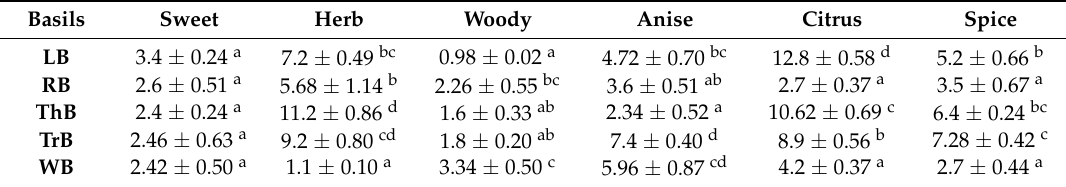
Table 4. The mean intensity values of the six attributes for the five Ocimum spp. essential oils in descriptive sensory evaluation.